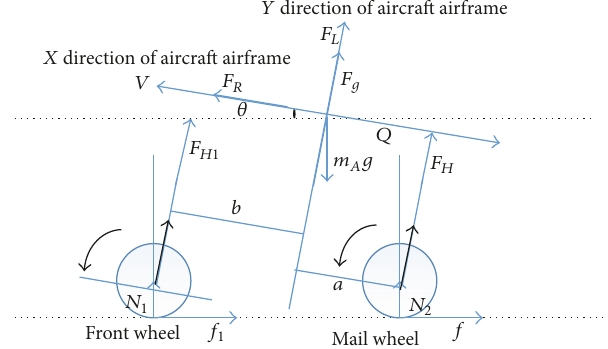
Figure 3: The force analysis of